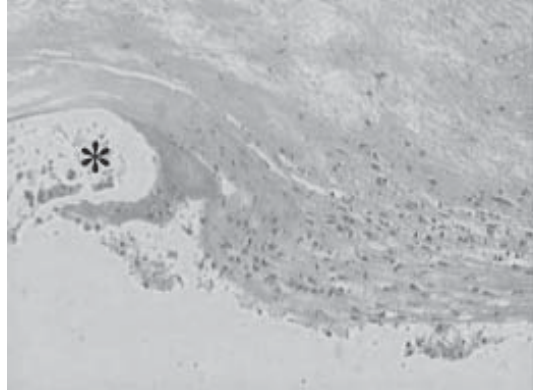
Fig. 2 - Presence of significant inflammatory infiltrate predominantly at the contact site of the mesh of the stent (marked with an asterisk) with the coronary artery